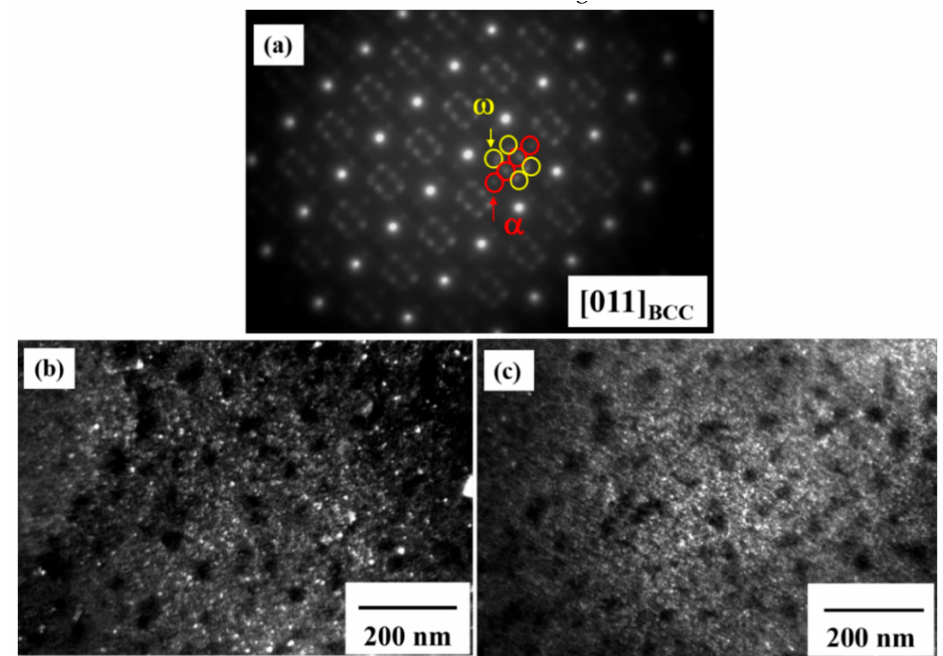
Figure 5. Transmission electron microscopy (TEM) results of the NbTa-rich region in the as-cast alloy: ( a ) selected area di ff raction pattern (SADP) of the [011] BCC zone axis; ( b ) dark-field image taken from the α spot, as highlighted by the red arrow in SADP; and ( c ) dark-field image taken from the ω spot, as highlighted by the yellow arrow in